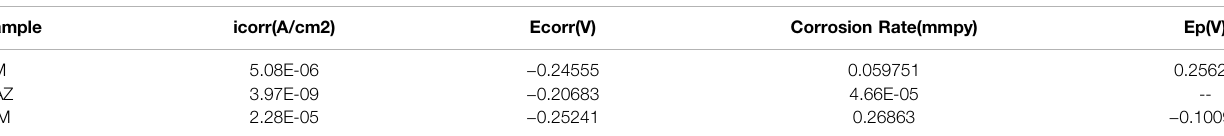
TABLE 13 | Polarization fi tting data of the three regions at 35 °